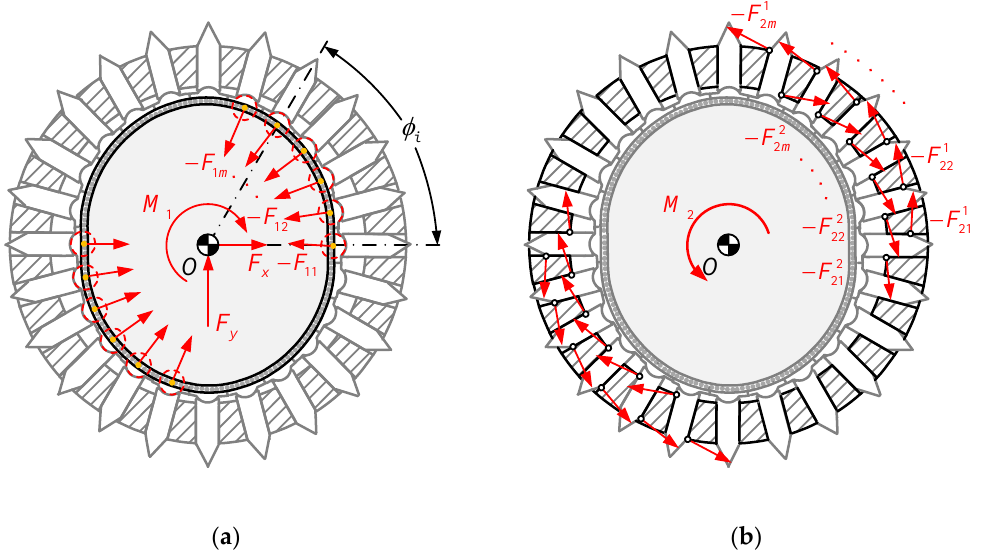
Figure 11. Force state of the components during the rise travel. ( a ) Wave generator; ( b ) Tooth carrier.